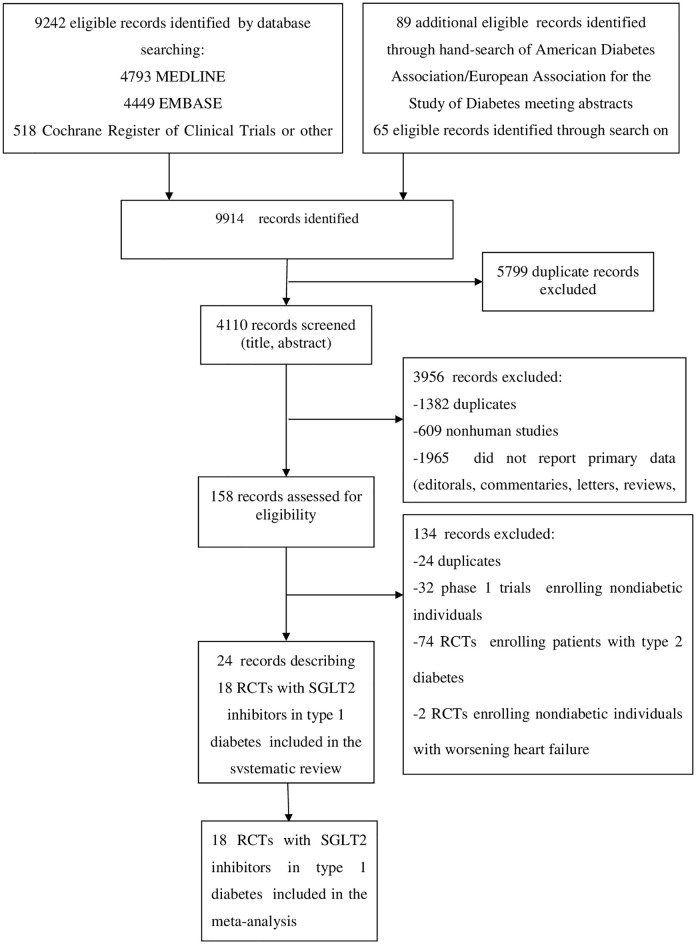
Evidence acquisition flow diagram.